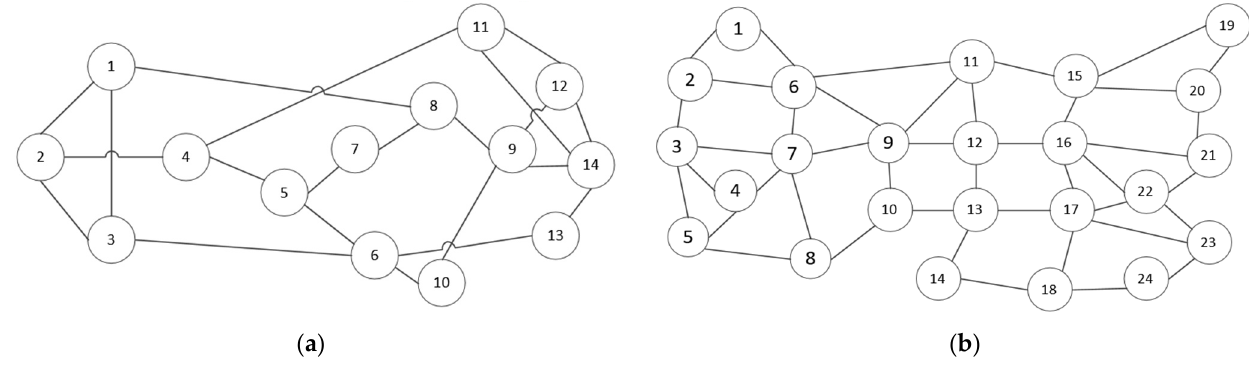
Figure 4. ( a ) NSFNET topology; ( b ) USNET topology.